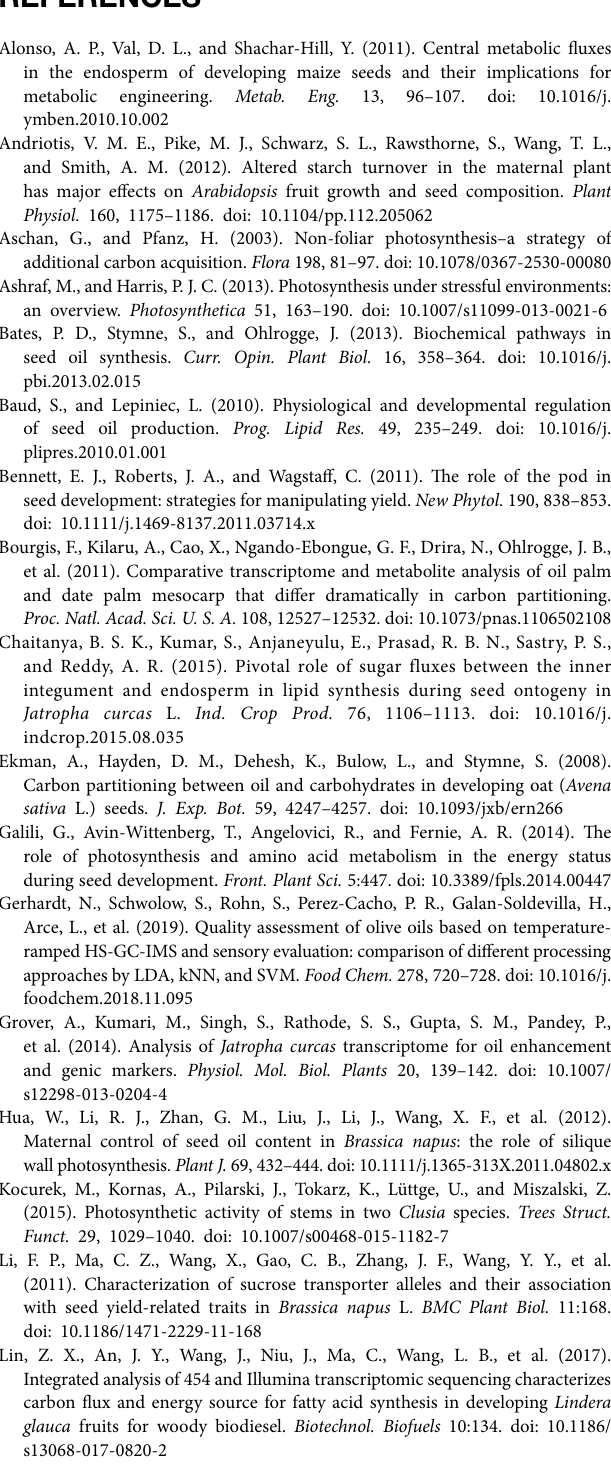
Supplementary Table 3 | DEPs identified during S. tonkinensis kernel